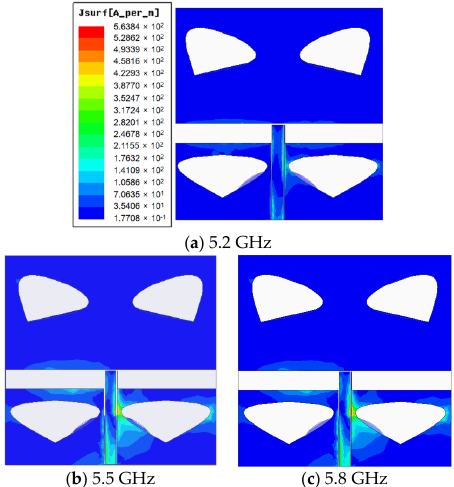
Figure 9. Simulated surface current distribution of the proposed novel antenna at frequencies of 5.2 ( a ), 5.5 ( b ) and 5.8 ( c ) GHz.